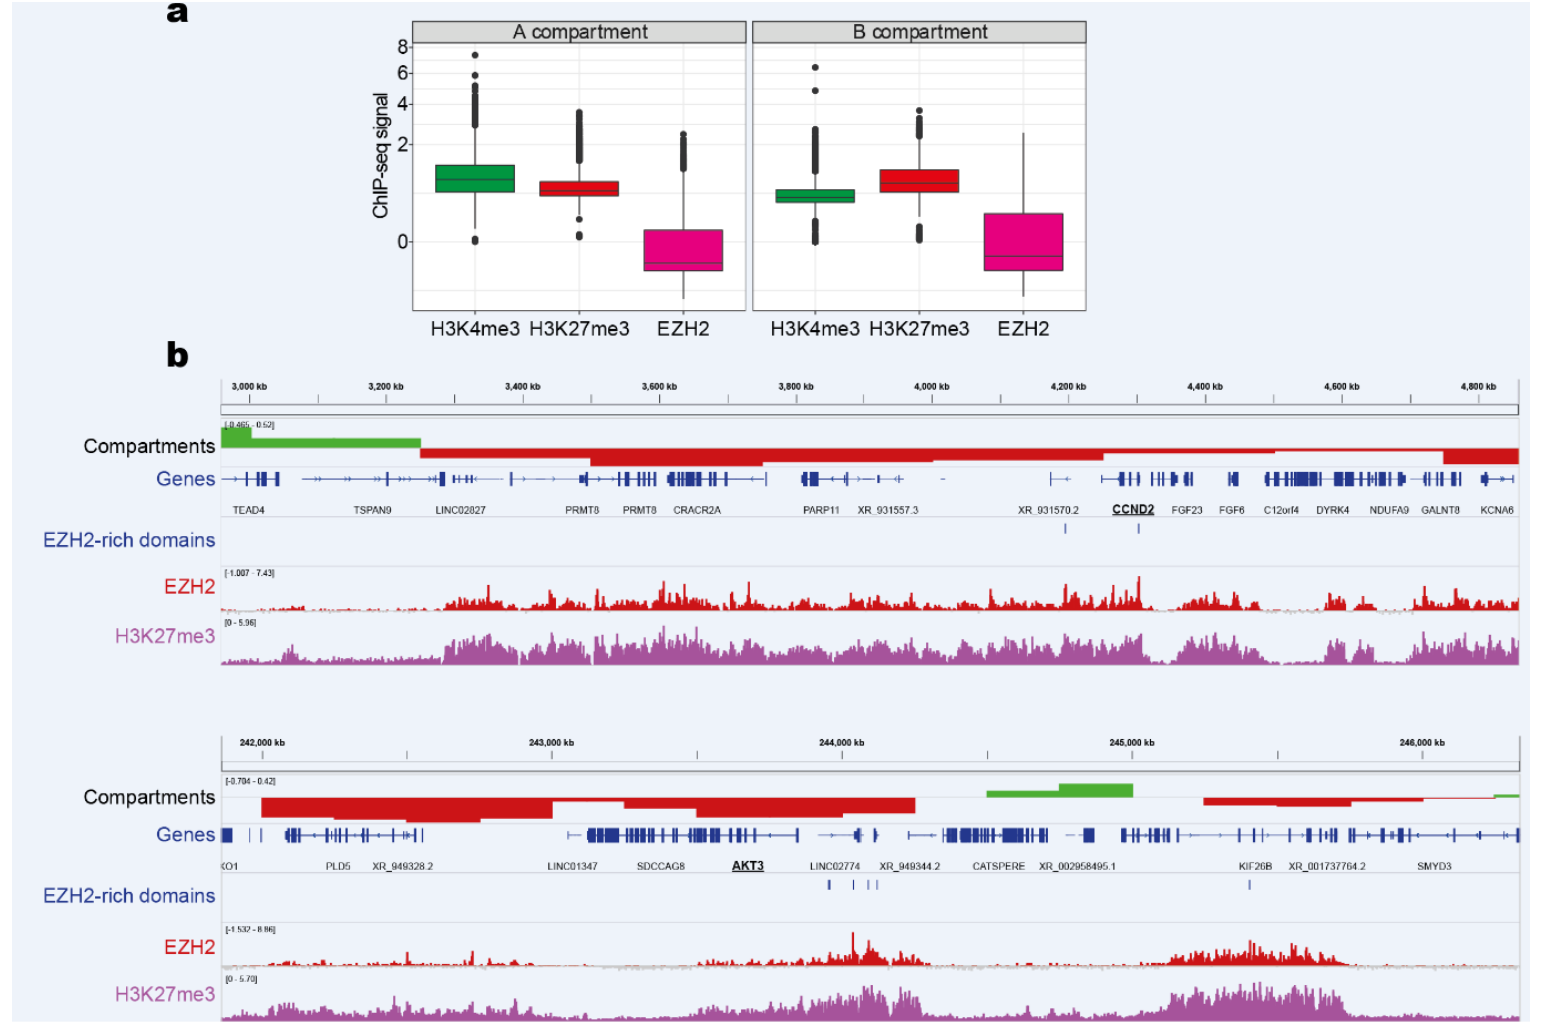
Figure 5: EZH2- rich domains are associated with repressive compartments in HeLa-S3. a) EZH2 enrich- ment at A/B com- partments in HeLa-S3 cells. A/B compart- ments were iden- tified with in situ Hi-C from the HeLa-S3 cell line using the 4D Nu- cleome Data Por- tal. b) IGV tracks of the A/B com- partments and EZH2-rich do- mains in the CCND2 and AKT3 locus. The tracks of EZH2 and H3K27me3 are shown. The region analyzed shows clear com- partmentalization between B com- partments and EZH2-rich do-